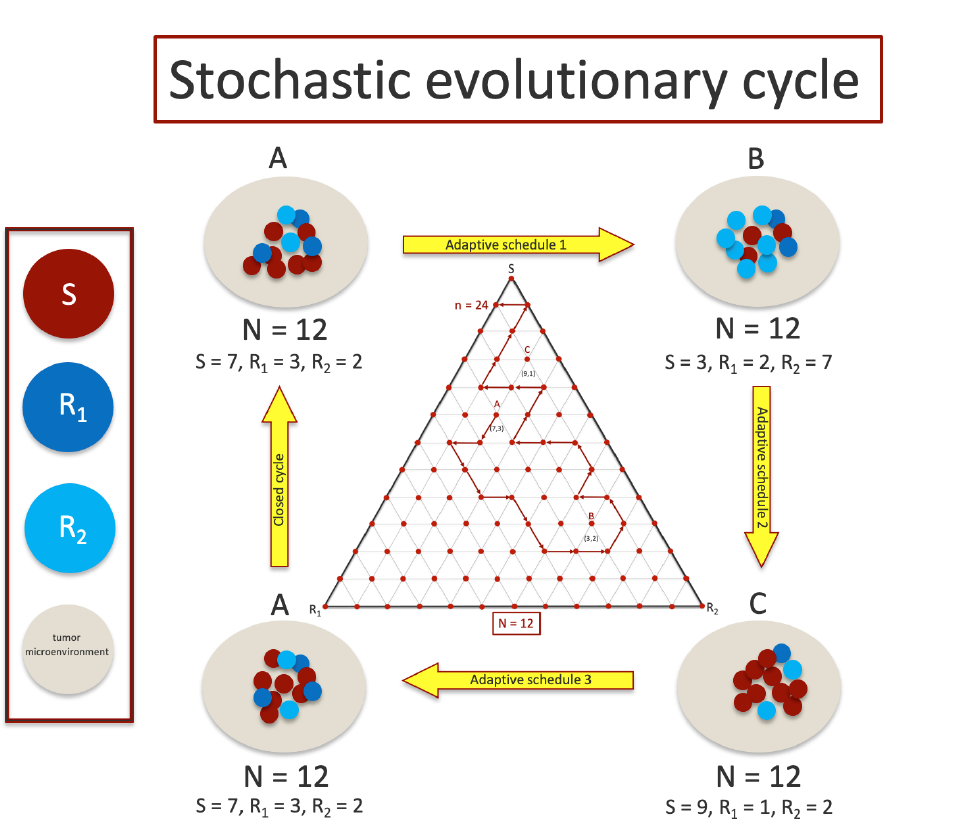
Figure 1. A sequence of adaptive chemoschedules that lock the tumor in a closed evolutionary cycle is difficult to achieve for finite cell (shown for N = 12) populations since sub-population frequencies fluctuate stochastically and are difficult to measure with precision. Middle inset shows a discrete tri-linear plot of a stochastic realization in the ( S , R 1 , R 2 ) plane, with n = 24 steps, starting at point A , using the chemoschedule designed from the deterministic ( N → ∞ )